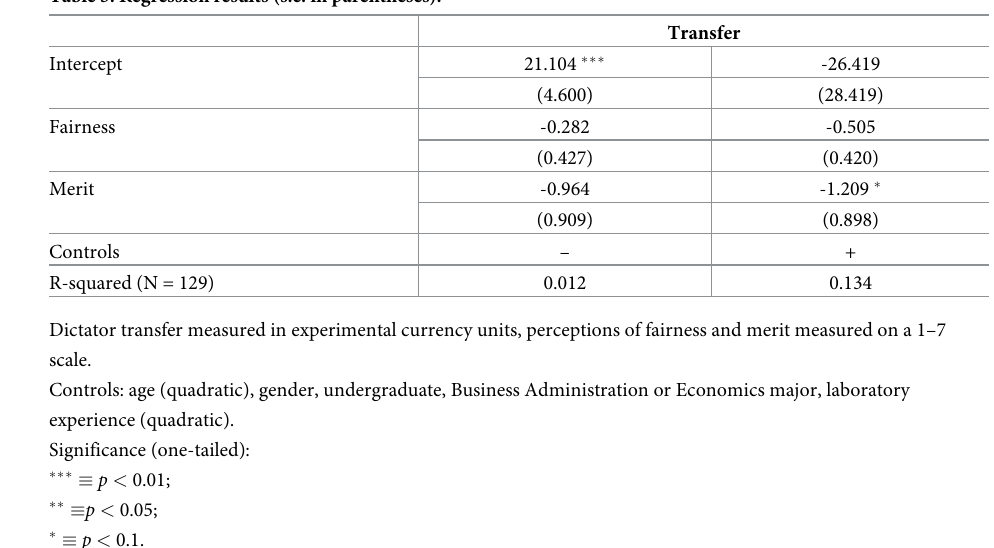
Table 3. Regression results (s.e. in